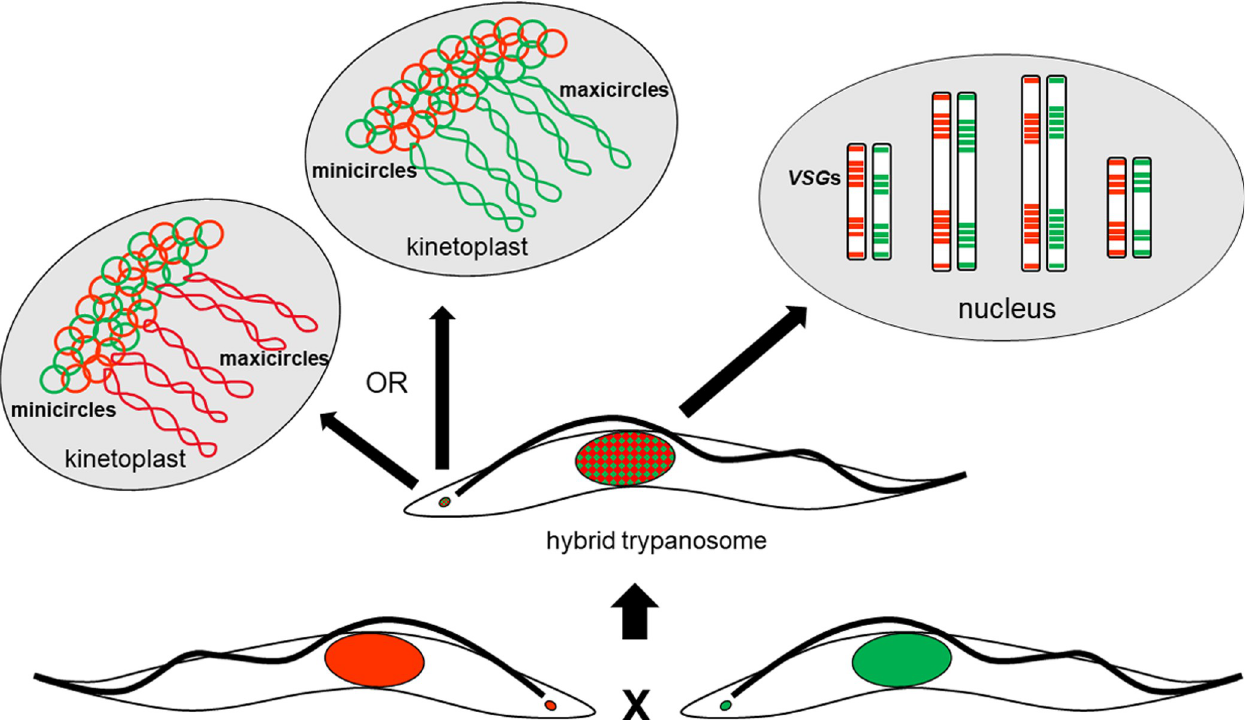
Fig 7. Modes of inheritance of nuclear and kinetoplast DNA. Diagram summarizing the different modes of inheritance of nuclear and mitochondrial genomes.